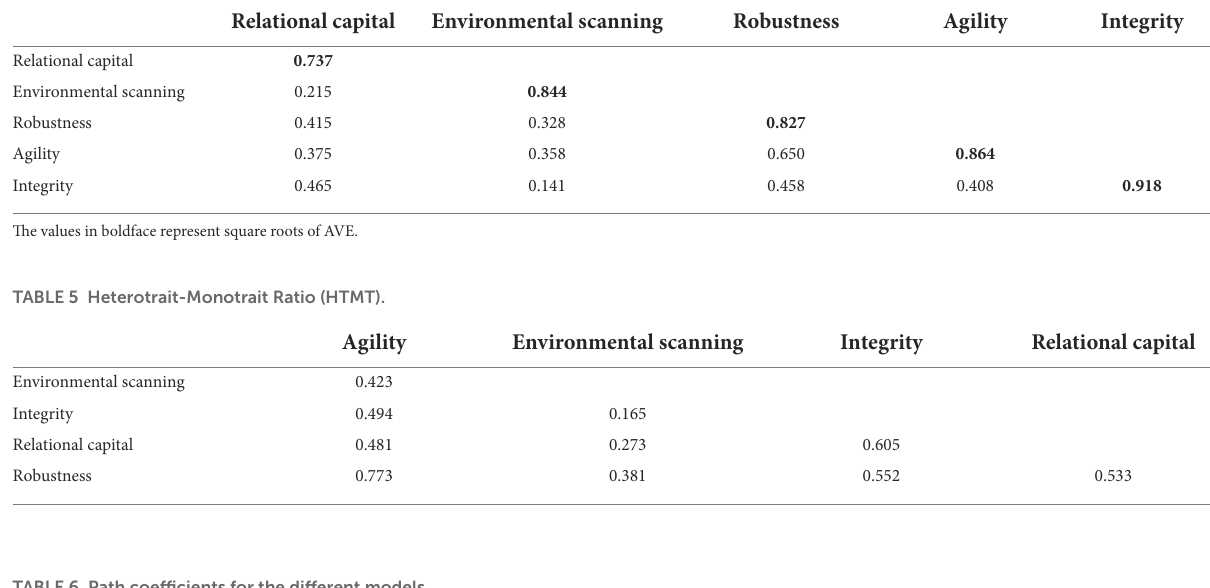
TABLE 6 Path coefficients for the different